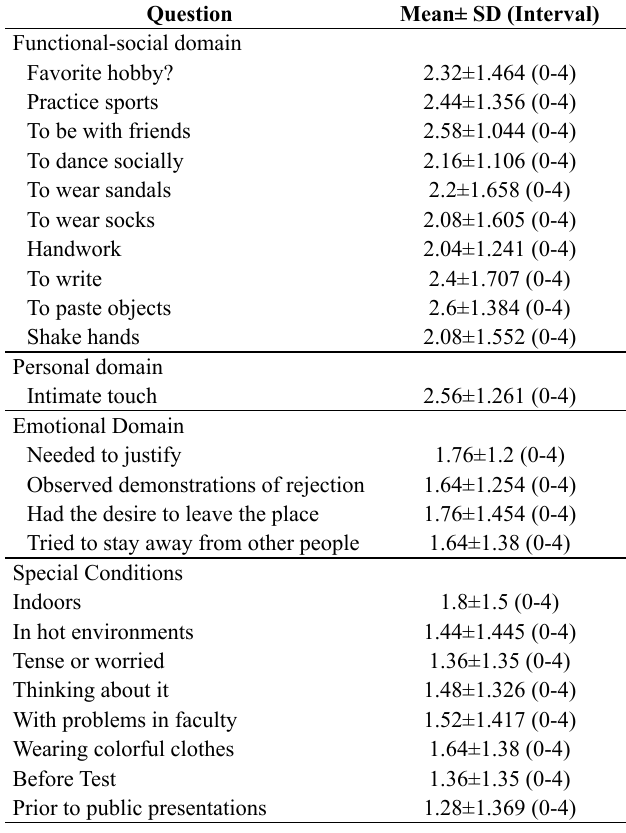
Table 8: Quality of life analysis in the functional-social, personal and emotional domains and in special conditions of the 25 Physical Edu- cation students with primary hyperhidrosis of a private university of Aracaju-SE, from August to November 2017, according to the classi- fication of the quality of life questionnaire 24,25 .